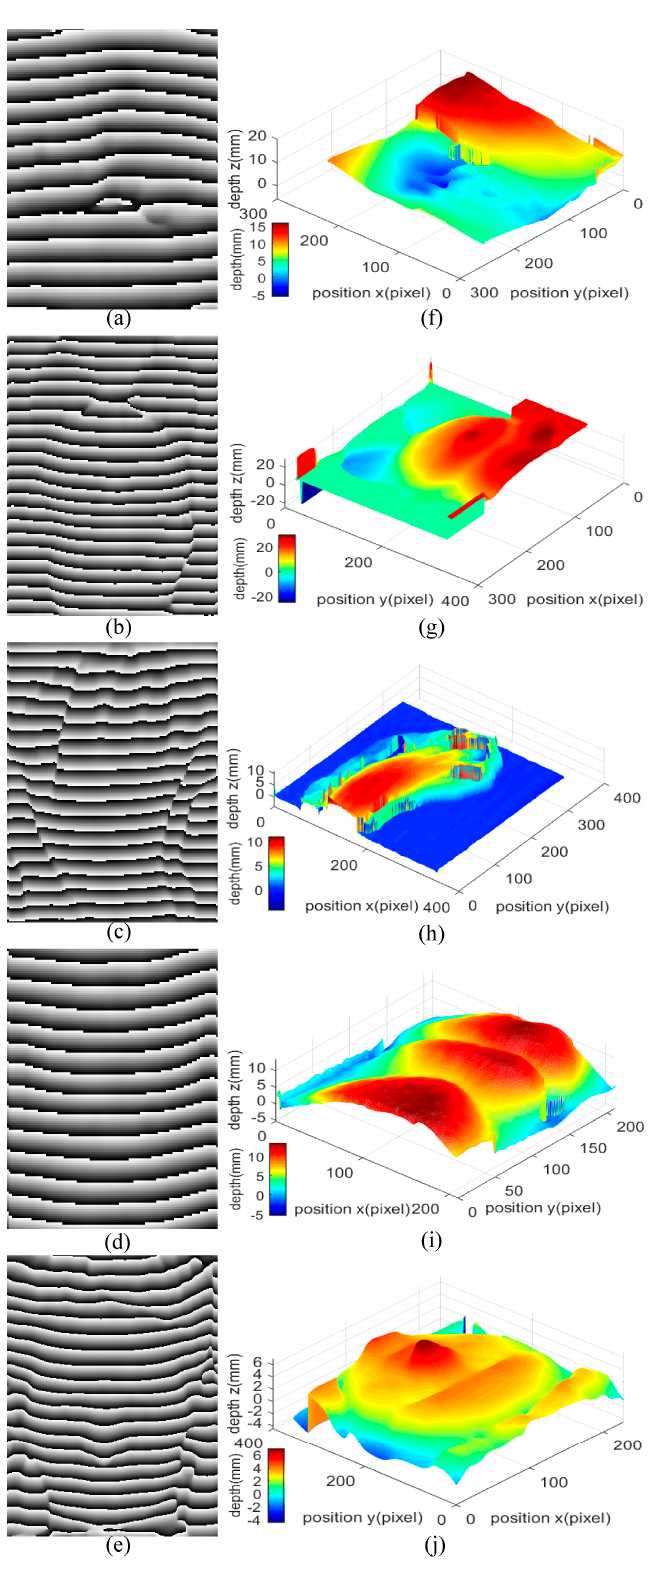
Figure 4. 2D phase maps of ( a ) eye, ( b ) doll, ( c ) hand, ( d ) lip and ( e ) real human face. 3D reconstruction images of ( f ) eye, ( g ) doll, ( h ) hand, ( i ) lip, and ( j ) real human face.